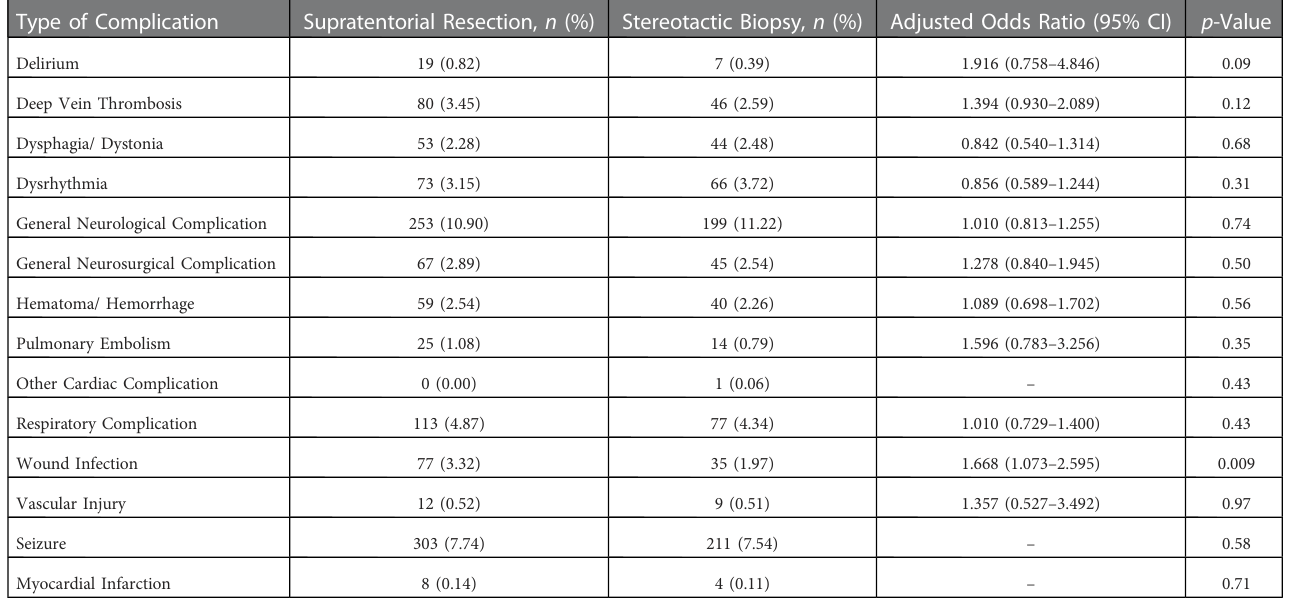
TABLE 3 Frequency of individual complications associated with maximal safe resection and stereotactic biopsy procedures.